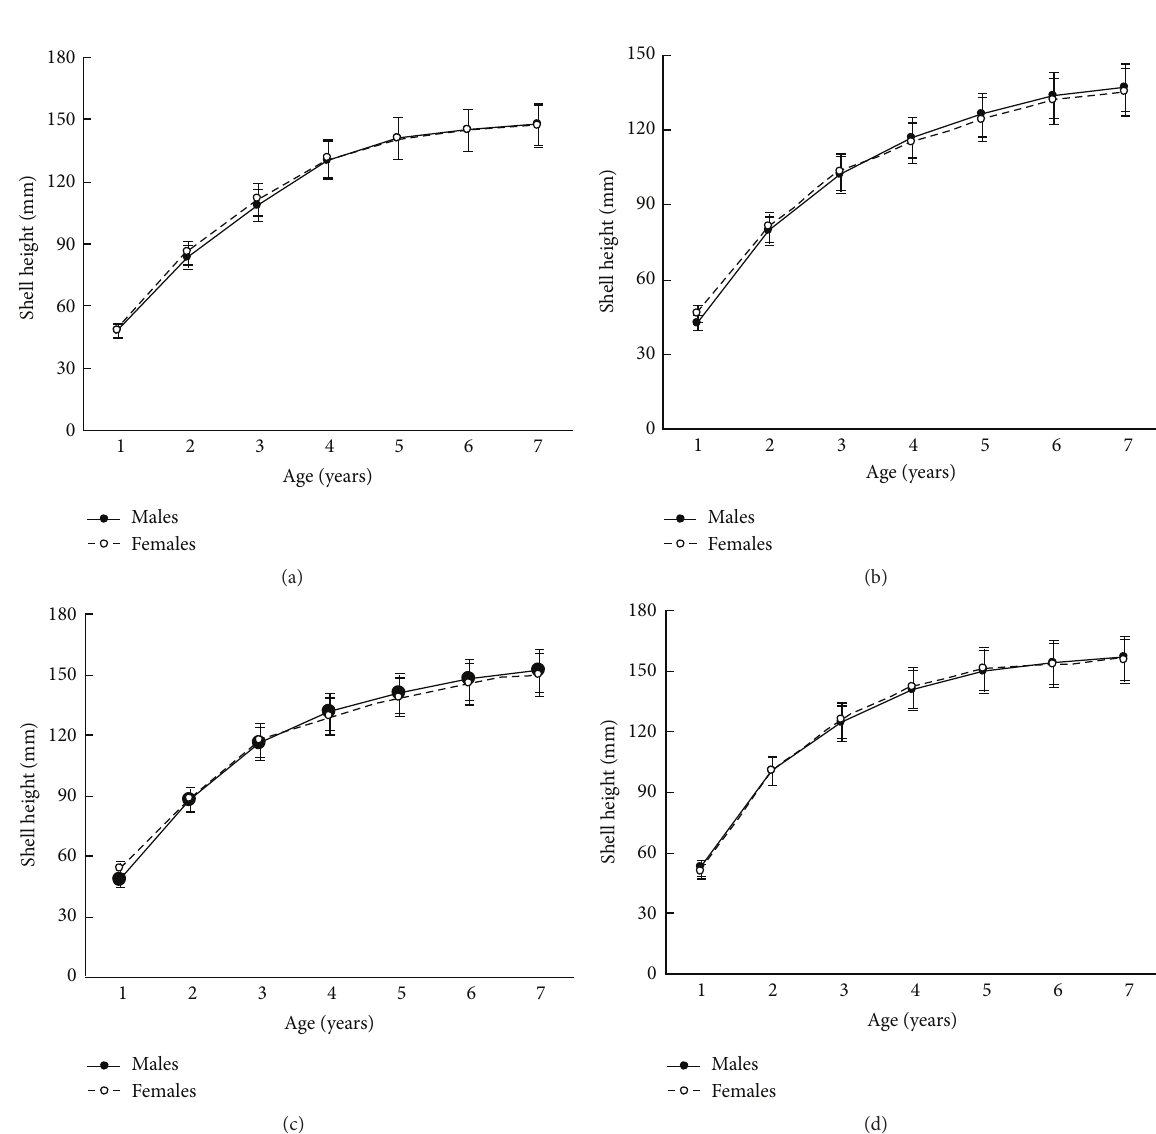
The size and weight parameters were statistically com- pared between the same aged males and females. The shell size parameters (height, length, and width) of the same aged